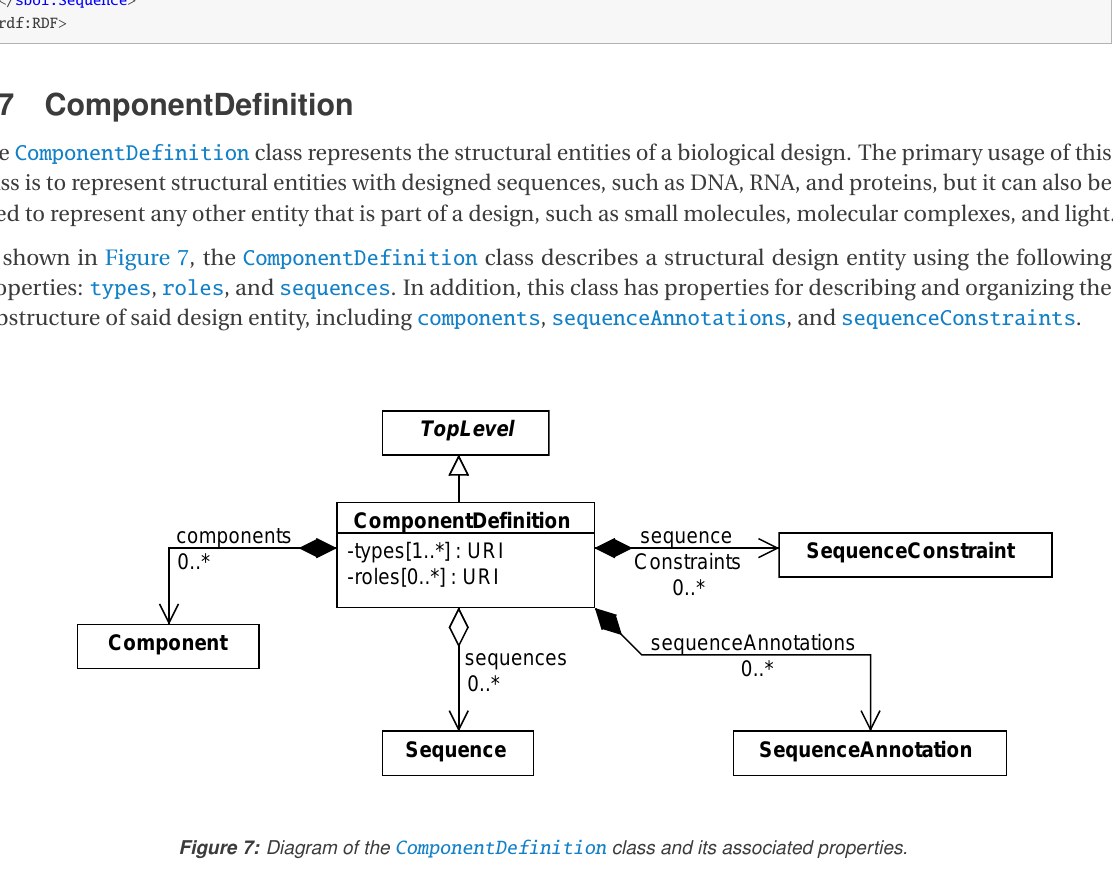
Figure 7: Diagram of the ComponentDefinition class and its associated